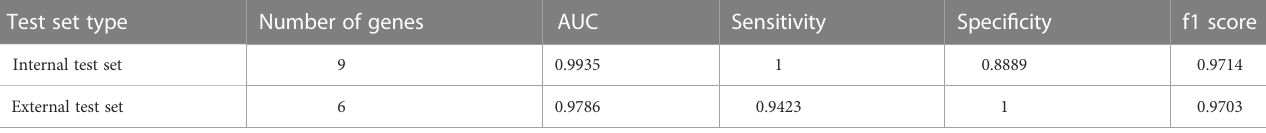
TABLE 1 AUC, sensitivity, speci fi city, and f1 score of the diagnostic model consisting of multiple genes on the internal and external test